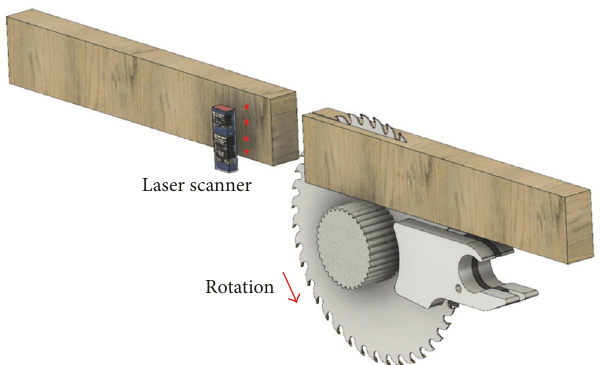
Figure 12: Schematic of scanning the surface of the workpiece after the cut by a laser scanner.